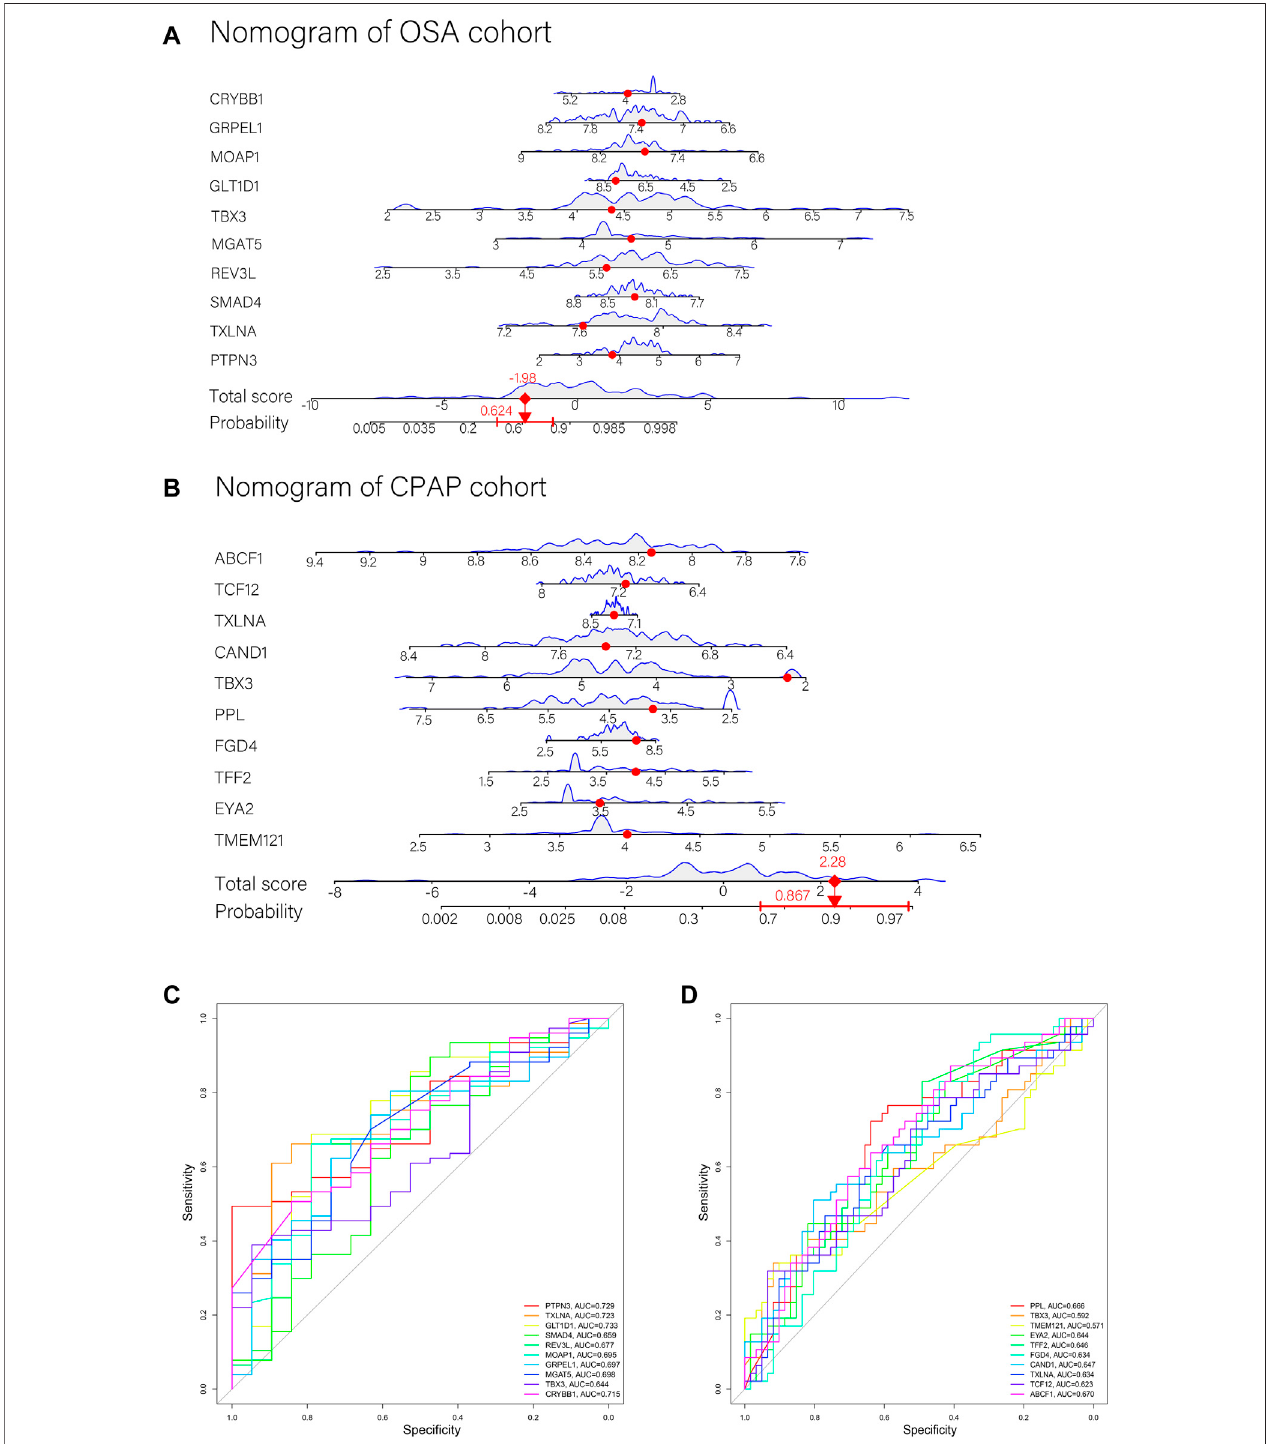
FIGURE 6 | (A,B) Nomograms with key genes were constructed for OSA risk prediction and CPAP therapeutic response. A point line is shown on the horizontal axis foreach variable. An axis fortotal scorewas plotted, and alinefor probability wasdrawn downward todeterminethe riskor responsetotreatment. (C) ROCcurves of ANN model genes in the OSA cohort. (D) ROC curves of ANN model genes in the CPAP cohort.